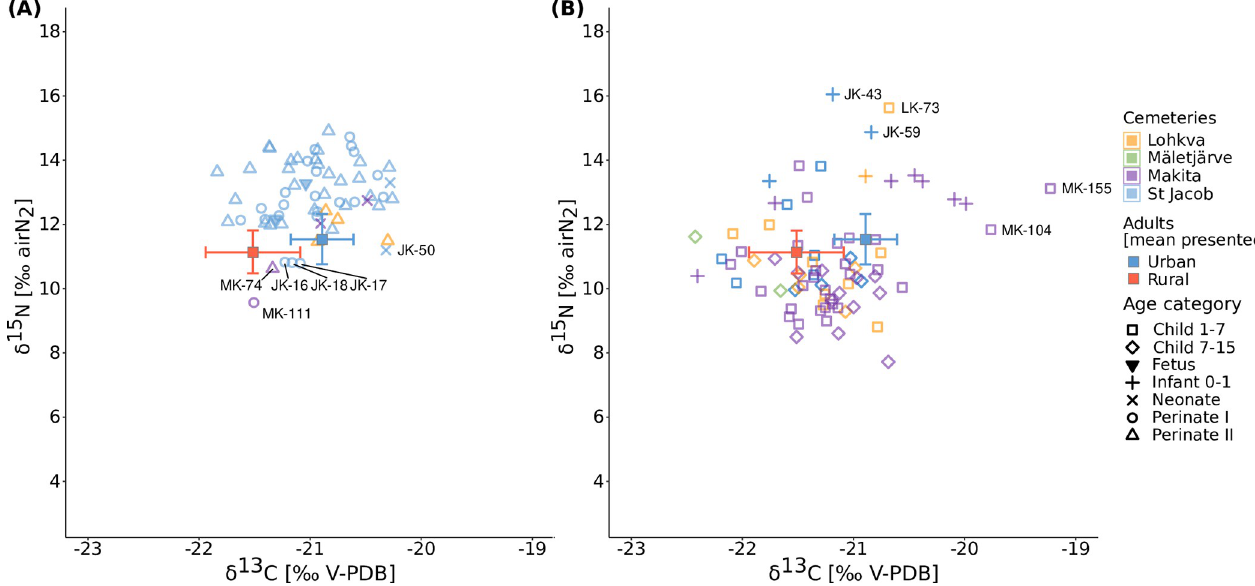
Fig 4. Carbon and nitrogen stable isotope values of the samples colored corresponding to the cemeteries used in this study, plotted with the urban and rural mean adult values (including both males and females). (A) Scatter plot of the fetuses, perinates I, perinates II, and neonates. (B) Scatter plot of the infants and older children. The ID codes of the outliers and individuals with anomalous values discussed in the text are included.